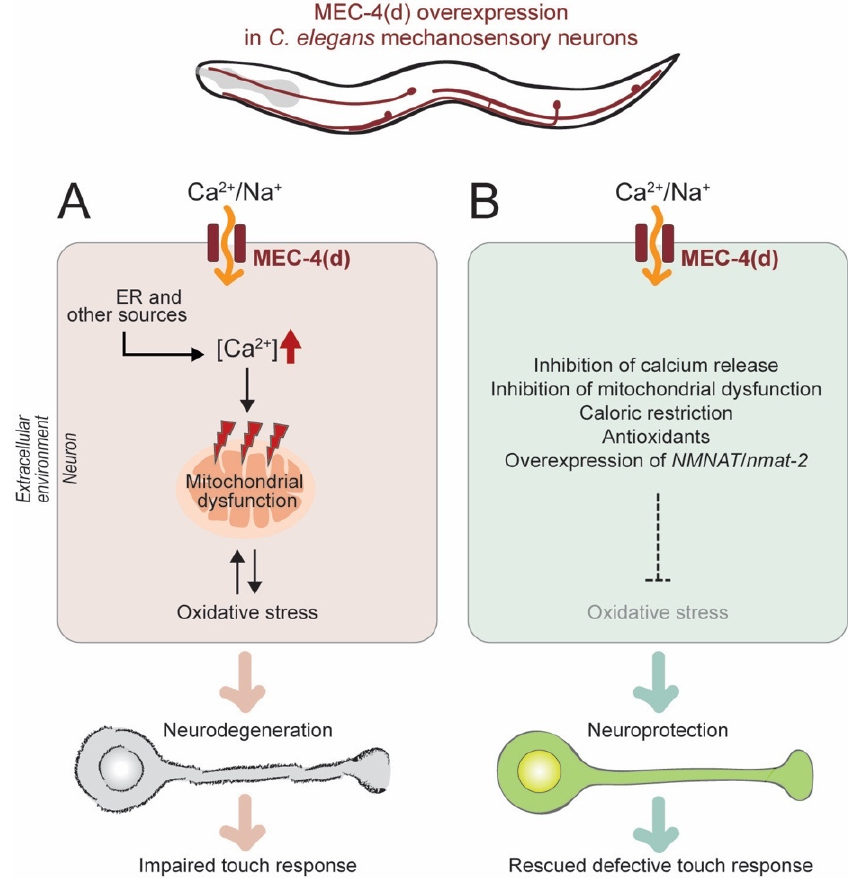
Figure 4. C. elegans models of chronic neuronal damage. ( A ) In the mec-4(d ) excitotoxic model of C. elegans mechanosensory neurons, intracellular calcium increase and mitochondrial dysfunction produce oxidative stress, which triggers neurodegeneration and eventually an impaired touch response. ( B ) Relieving oxidative stress with various strategies protects neurons against degeneration and rescues touch response defects.